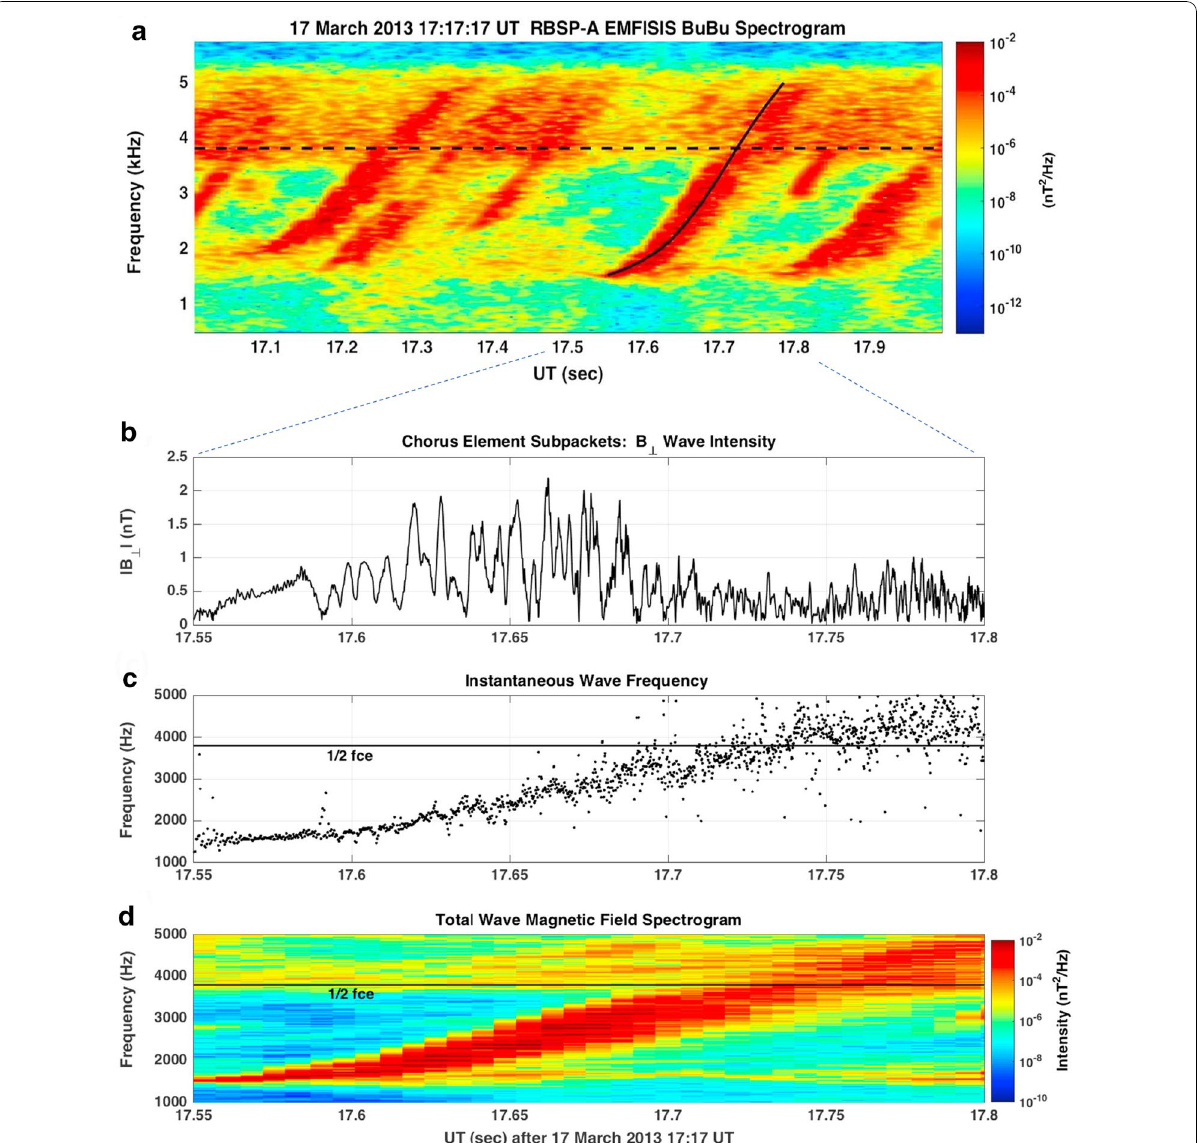
Fig. 7 Chorus observation. Chorus emissions and sub-packet structures of a single element observed by Van Allen Probe A (after Foster et al.